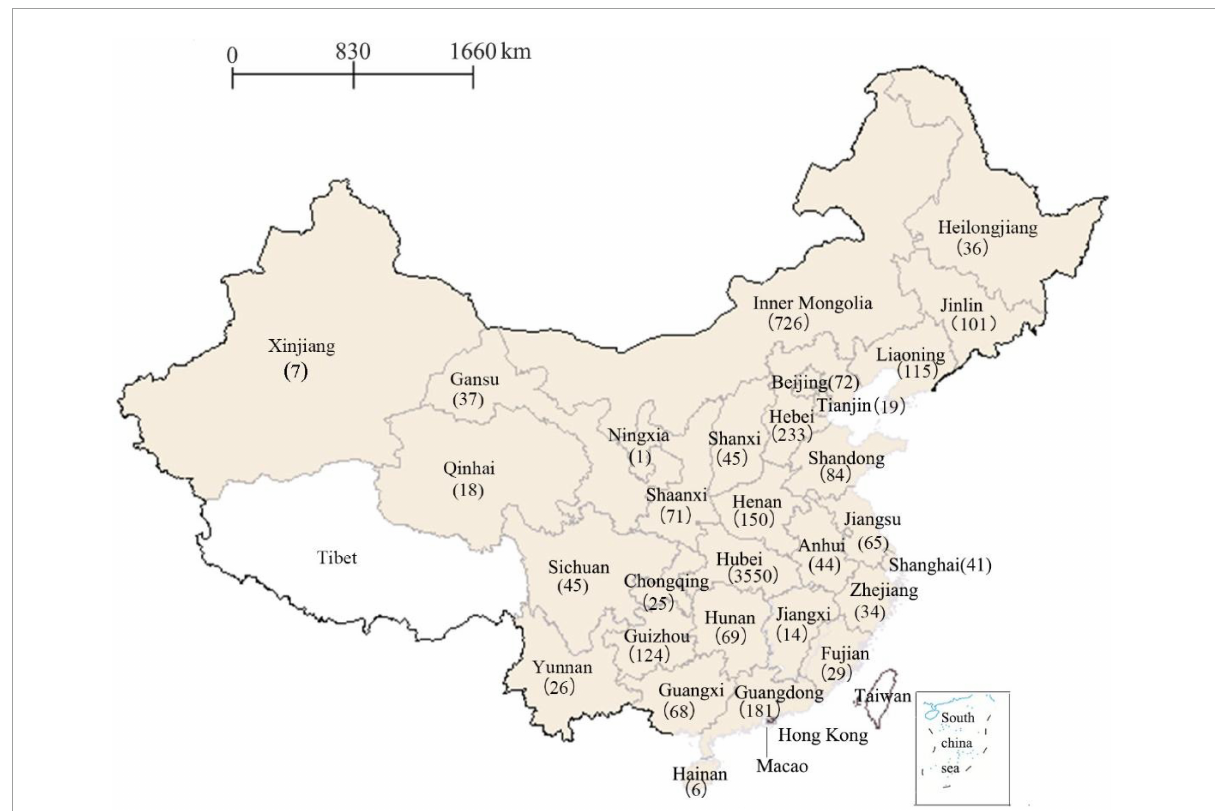
FIGURE1 A map displaying the provincial distribution of 6,036 undergraduates was drawn using Supermap iDesktop 8C (2017) and then converted into Microsoft Word format. Excluding Taiwan, Hong Kong, and Macao, there are 31 provinces in mainland China. The exact number in the map indicated that the 6,036 participants were unevenly distributed across 30 provinces (except for Tibet with white highlighted), and were mainly (3,550) recruited from Hubei